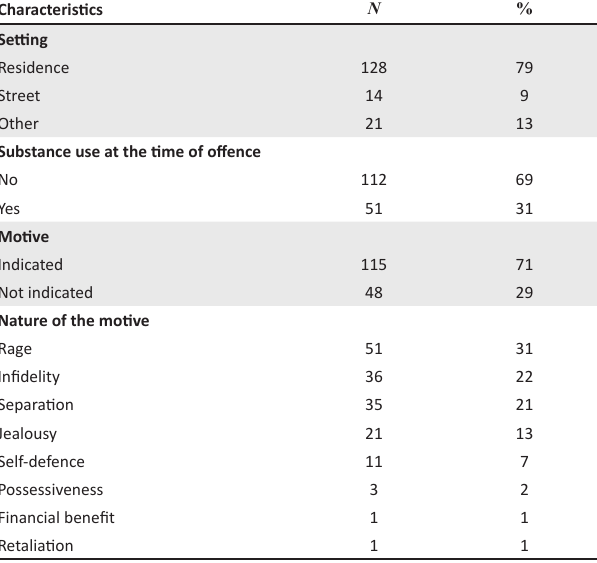
TABLE 2: (Continues...): Offence